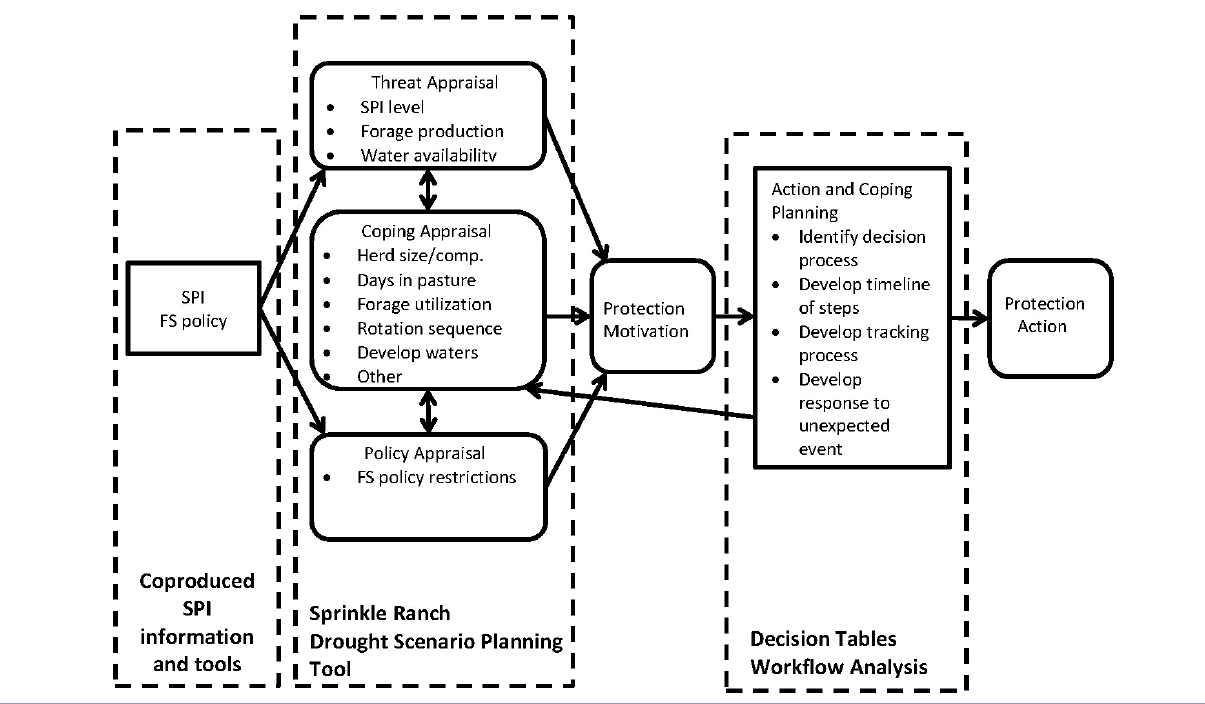
Fig. 2 . Codevelopment activities to increase preparation for drought on public rangelands based on collaborative protection motivation theory + health action process approach (C-PMT+HAPA). Note: SPI = Standard Precipitation Index; FS = U.S. Forest